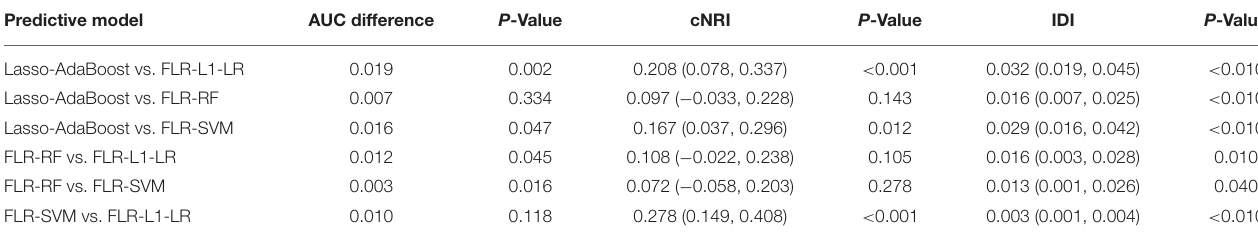
TABLE 2 | Comparison of discrimination performance of optimal prediction